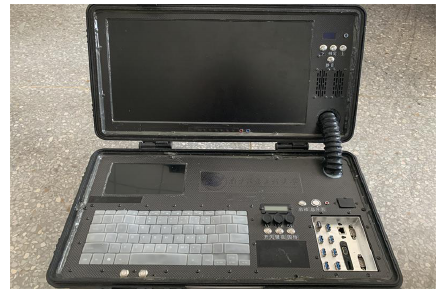
Figure 17. Autonomous underwater vehicle.